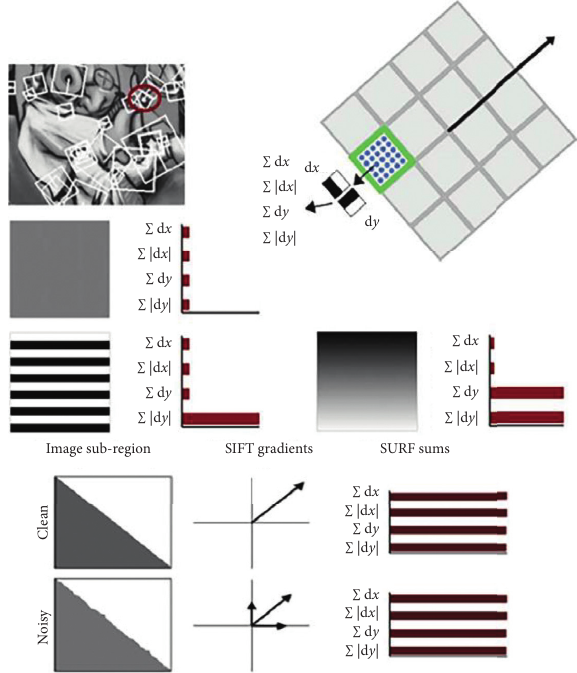
Figure 12: Process of SURF descriptor construction.